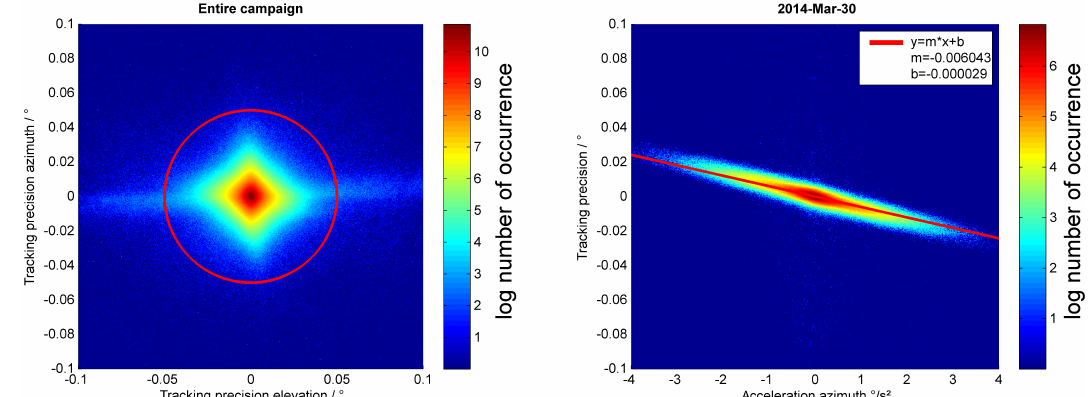
Figure 2. Both figures show occurrence of tracking errors in logarithmic color code. The left figure counts azimuth and elevation tracking errors for the entire campaign record. The red circle defines the desired 0.05 ◦ tracking precision. 98.7% of the data points are within the circle. The right figure shows azimuth tracking precision vs. angular azimuthal acceleration for a representative day with significant angular accelerations due to a rougher sea than other